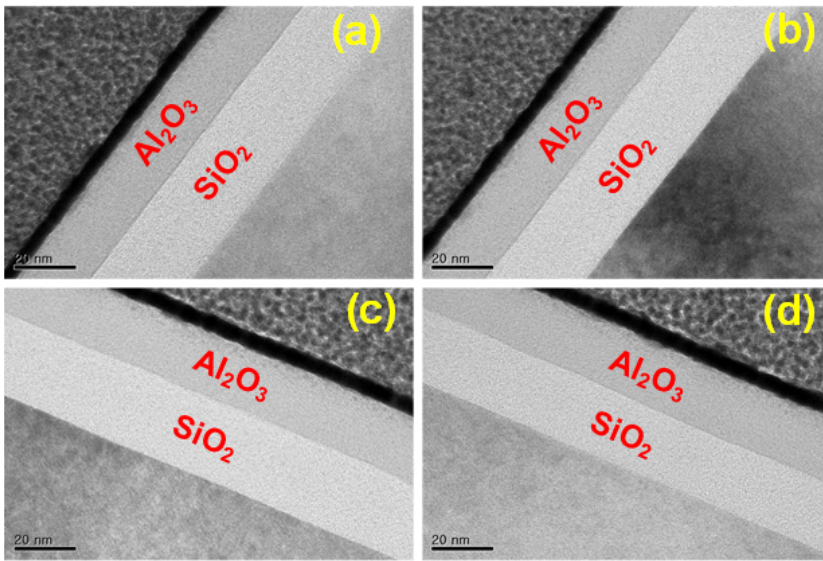
Figure 5. Transmission electron microscopy (TEM) images of an atomic layer deposition (ALD)-deposited Al 2 O 3 layer ( a ) before and after ( b ) 1-min, ( c ) 5-min and ( d ) 15-min vapor hydrogen fluoride (HF) etching.